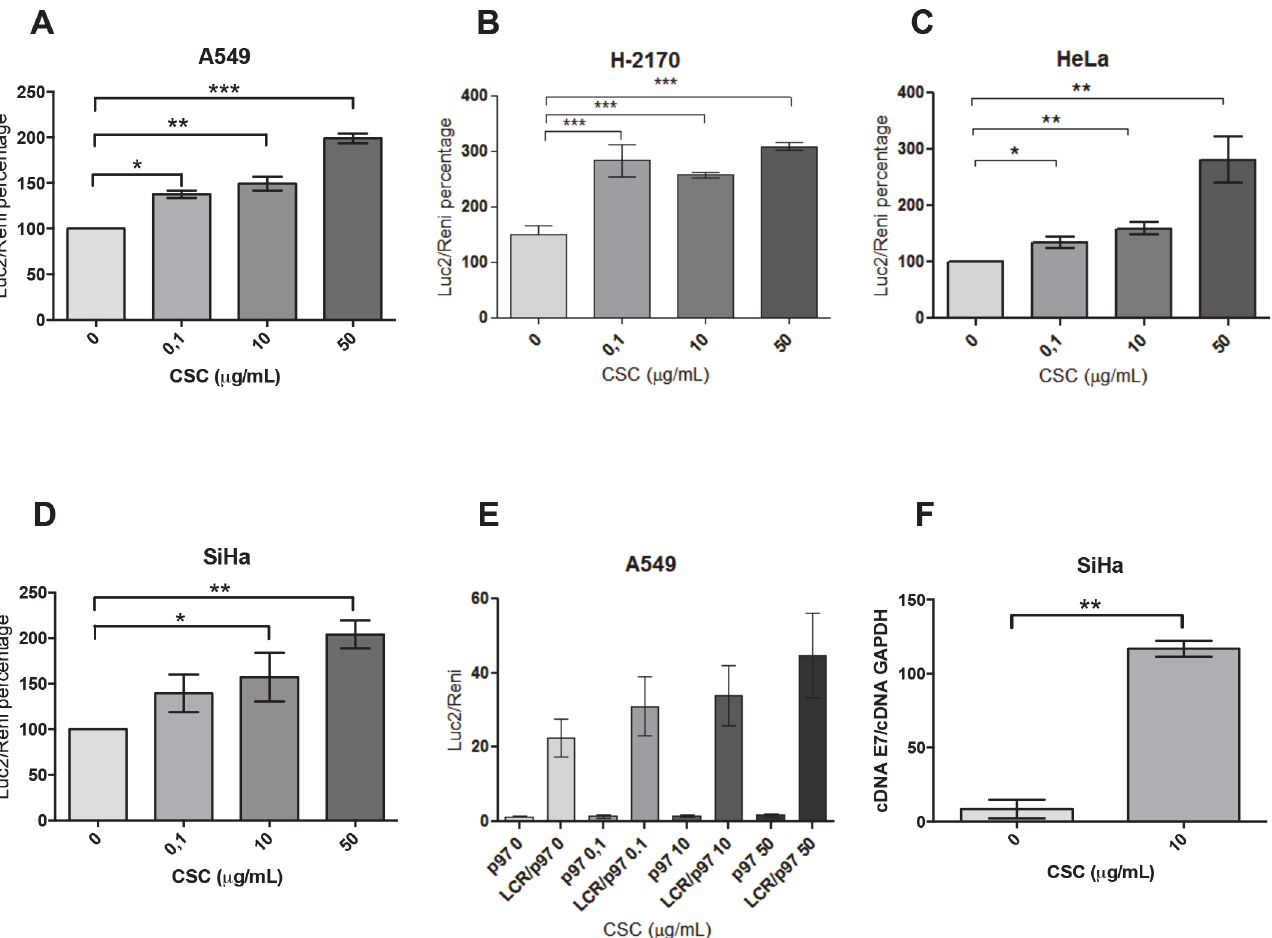
Fig 1. Cigarette smoke condensate (CSC) activates the HPV-16 p97 promoter in a dose-dependent manner in lung and cervical cancer cells. ( A ) A- 549 ( B ) H-2170 ( C ) HeLa and ( D ) SiHa cells were exposed to CSC (0.1 – 50 μ g/mL) for 16 hours after transfection with the pmiR-GLO construct containing the complete HPV-16 LCR/p97 region. ( E ) A-549 cells were transfected with the pmiR-GLO containing only the HPV-16 p97 promoter and the luciferase activity was compared with those cells transfected with the full HPV-16 LCR/p97 region. ( F ) SiHa cells were exposed to 10 μ g/mL CSC and the levels of E7 transcripts were measured using RT-qPCR. The graphs are representative of three independent experiments. ( * = p < 0.05; ** = p < 0.01; *** = p < 0.001, Luc2/Reni percentage ± SEM).